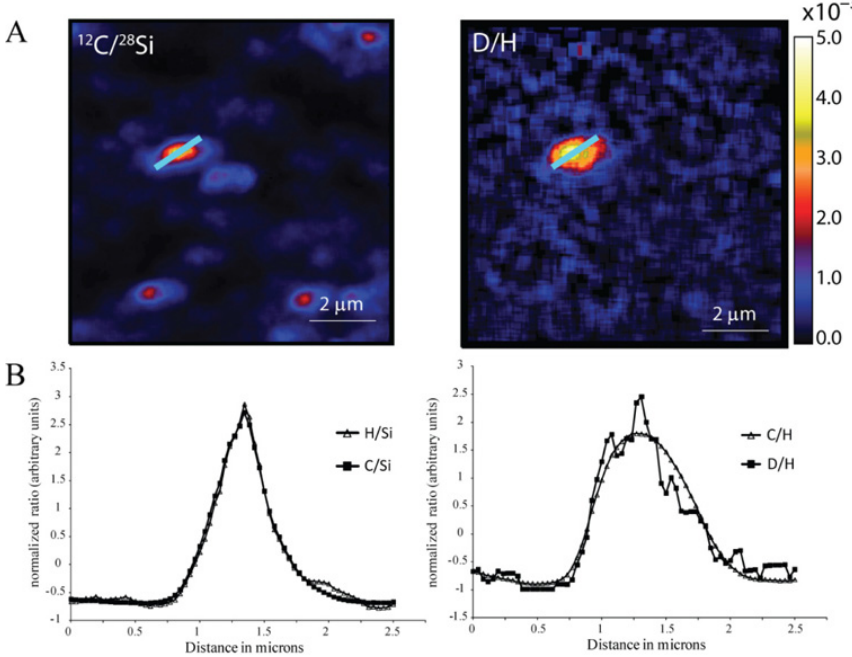
Figure 10. NanoSIMS ratio images of the matrix of Orgueil meteorite (A) reveals the location of C rich particles, from the C/Si image. The corresponding D/H image shows a D-rich hot spot, inside which we can make profiles (B) along the blue bar. H/Si and C/Si profiles indicate that C and H are intimately associated, consistent with organic matter constituting this particle. C/H and D/H profiles show that there is no diffusion of D from the